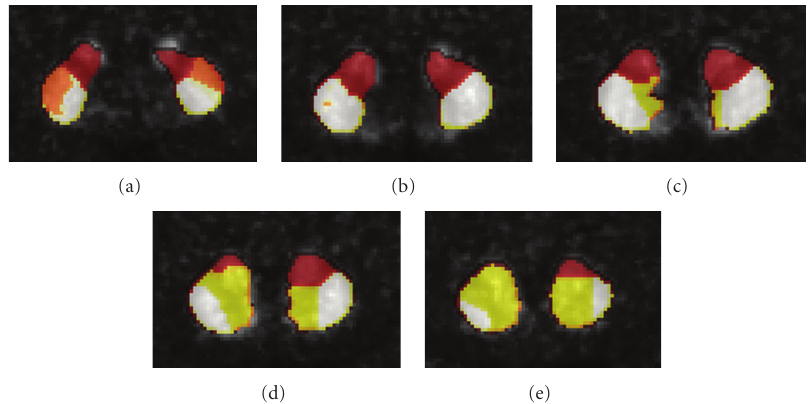
Figure 4: Segmentation of the right and left striatum using the automatic method. Coronal (a) slice 115, (b) slice 112, (c) slice 109, (d) slice 106, and (e) slice 103 magnified to show only the striatum. The orange and white clusters correspond, respectively, to the posterior and the anterior putamen, the red cluster corresponds to the caudate and, the yellow cluster corresponds to the ventral striatum. It can be seen that ventral striatum contains also a part of the caudate head.